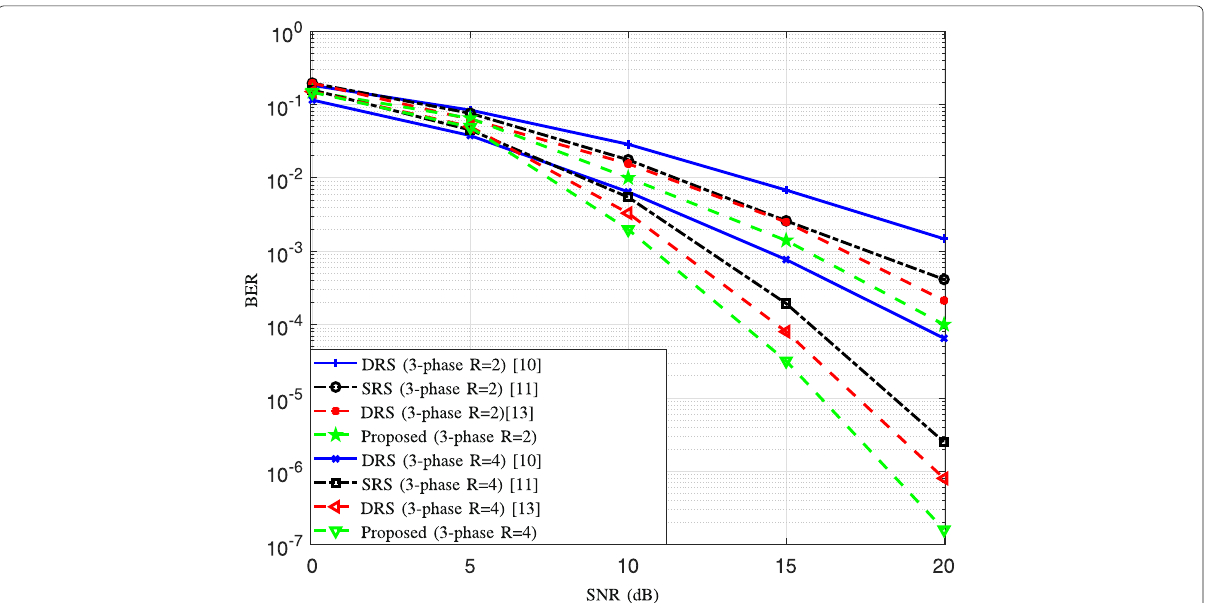
Fig. 3 BER versus SNR for several single and dual relay selection strategies using the three-phase relaying protocol with R = { 2,4 } and 4-QAM